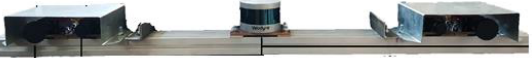
Figure 6. Camera and LiDAR system with for cameras and one LiDAR